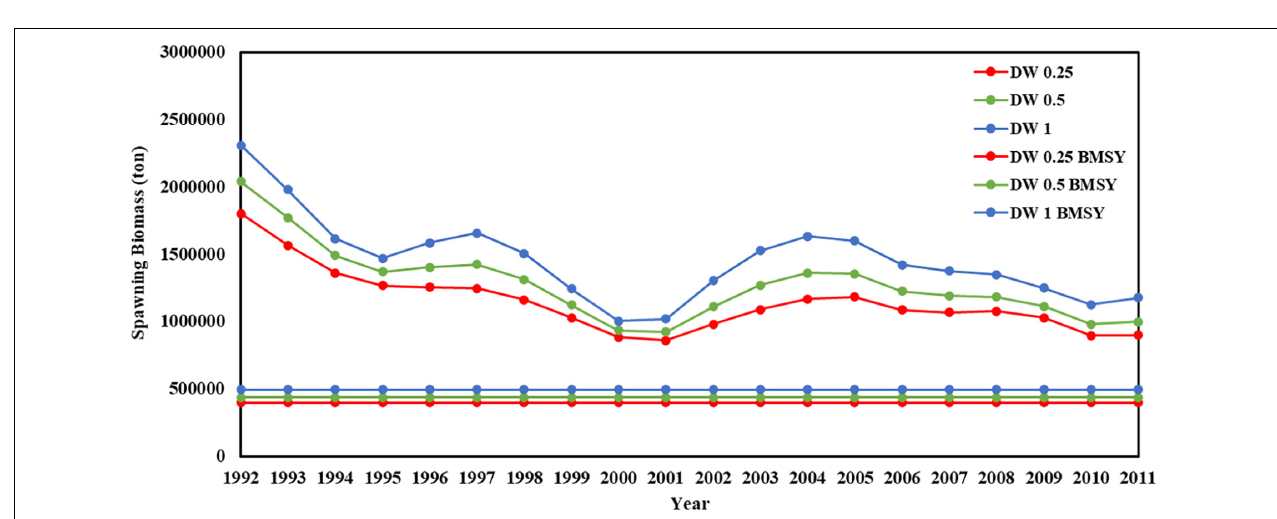
FIGURE 7 | Spawning biomass and BMSY in 1992–2011 years (red line present weights in 0.25, green line present weight in 0.5, blue line present weight in